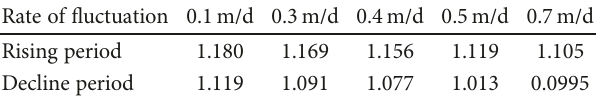
Figure 19: The stability calculation results without impounding of the reservoir water level (unit: m). Table 3: The calculation results of FOS during the rise and decline of the reservoir water